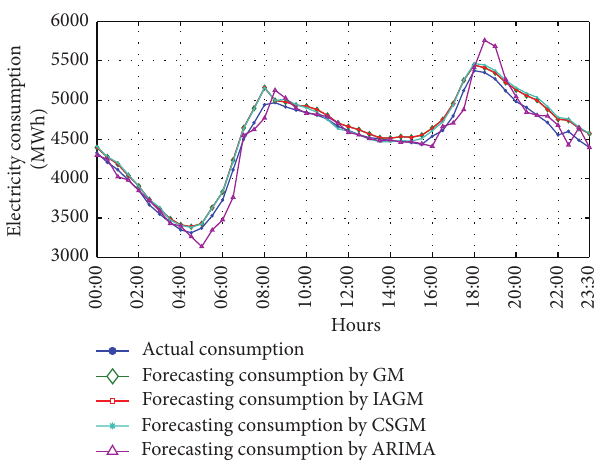
Figure 5: The forecasting results and actual values.